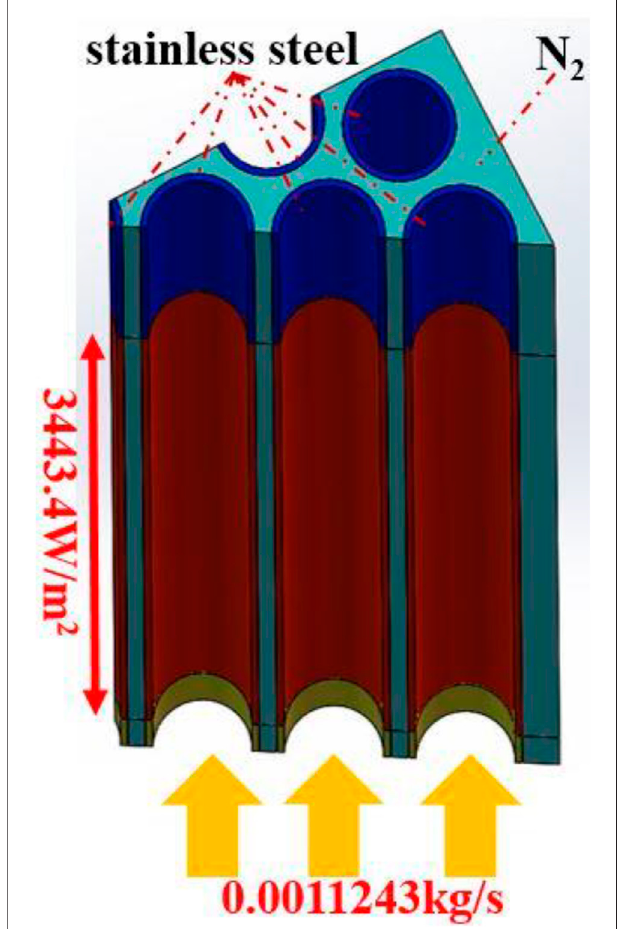
FIGURE 8 | Schematic of the simulation model of the test